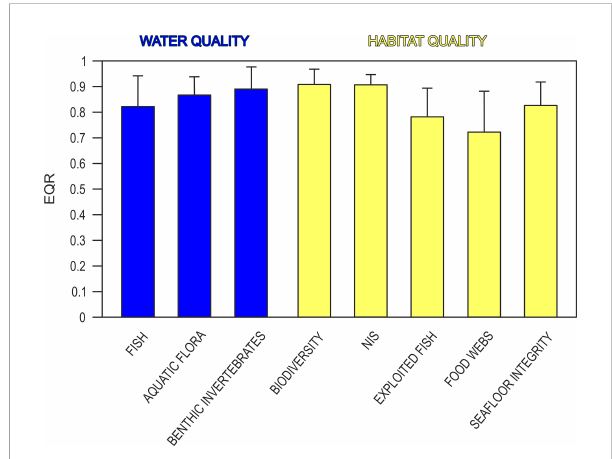
FIGURE 3 Mean EQR scores according to the indices of Water quality (blue) and Habitat quality (yellow).